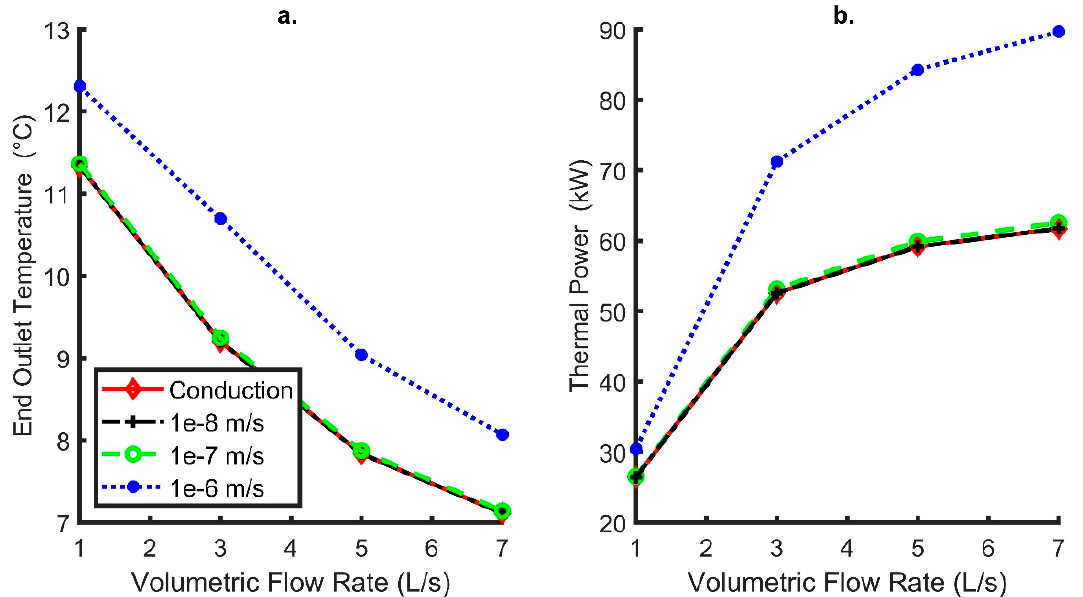
Figure 7. Six-month simulation of heat extraction only from DBHE, with constant inlet temperature of 5 °C and varying the constant heat transfer fluid flow rate. ( a ) shows the impact of varying DBHE internal fluid flow rate and groundwater Darcy velocity on DBHE outlet temperature; ( b ) shows the impact on final thermal output from DBHE after 6 months. Groundwater Darcy velocity is varied between 0 (conduction only) and 1e-6 m/s. Outlet temperatures and thermal powers were recorded at the end of the simulation.